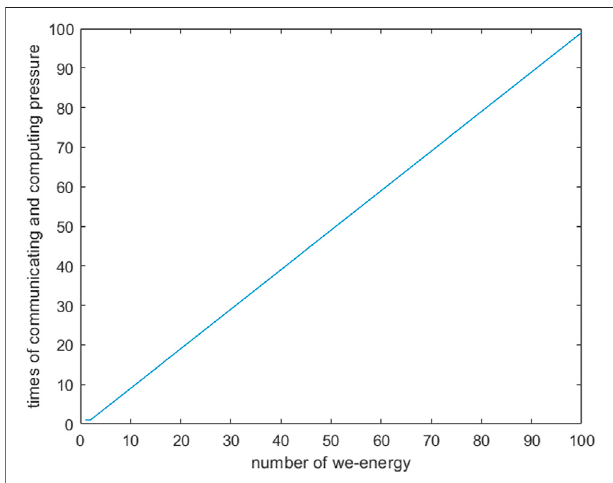
FIGURE 11 | Times of communicating and computing pressure.